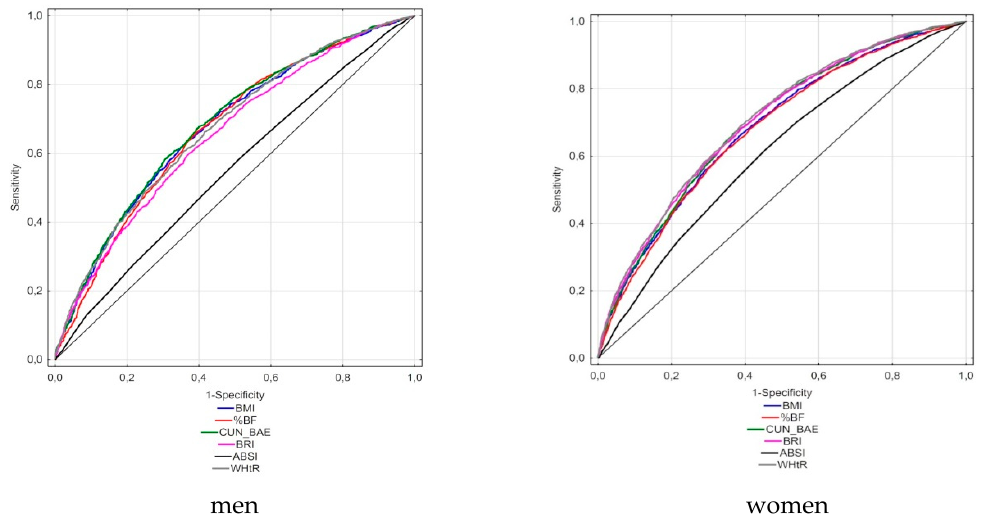
Figure 2. Receiver-operating characteristic curves of anthropometric indices to identify men and women with MetS (MetS modified: two or more components out of four, other than WC).